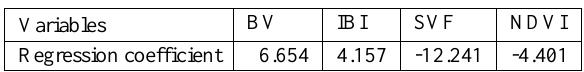
Table 3. PLS regression coefficient